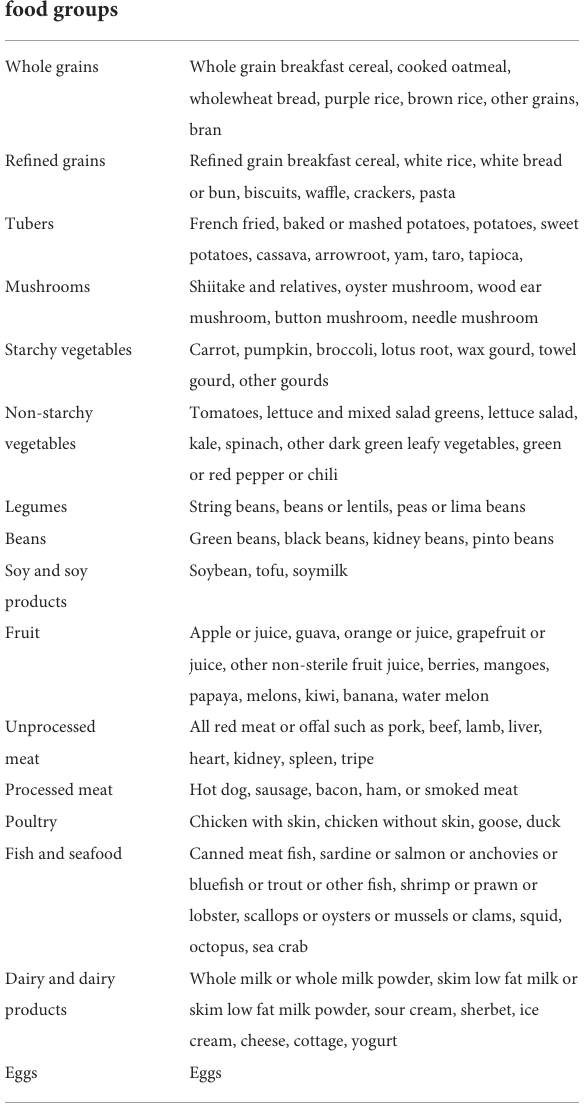
TABLE 1 Example of food items constituting the 16 food